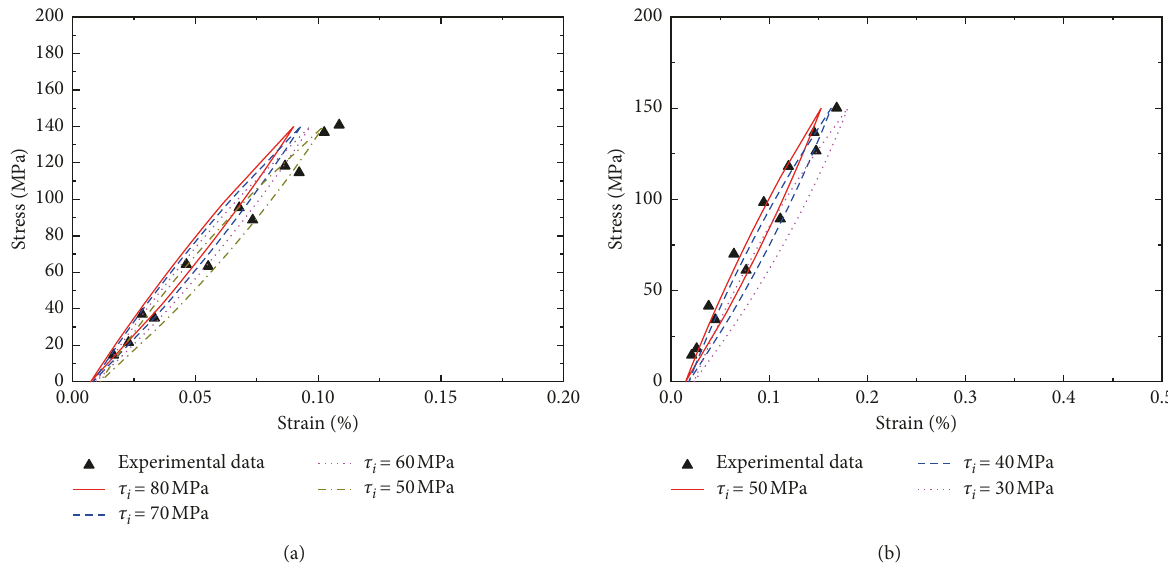
Figure 13: The experimental and predicted fatigue hysteresis loops of 2D Hi-Nicalon ™ SiC/SiC composite under (a) the fatigue peak stress of σ max � 140MPa for N � 13000 cycles and (b) the fatigue peak stress of σ max � 150MPa for N � 27000 cycles.